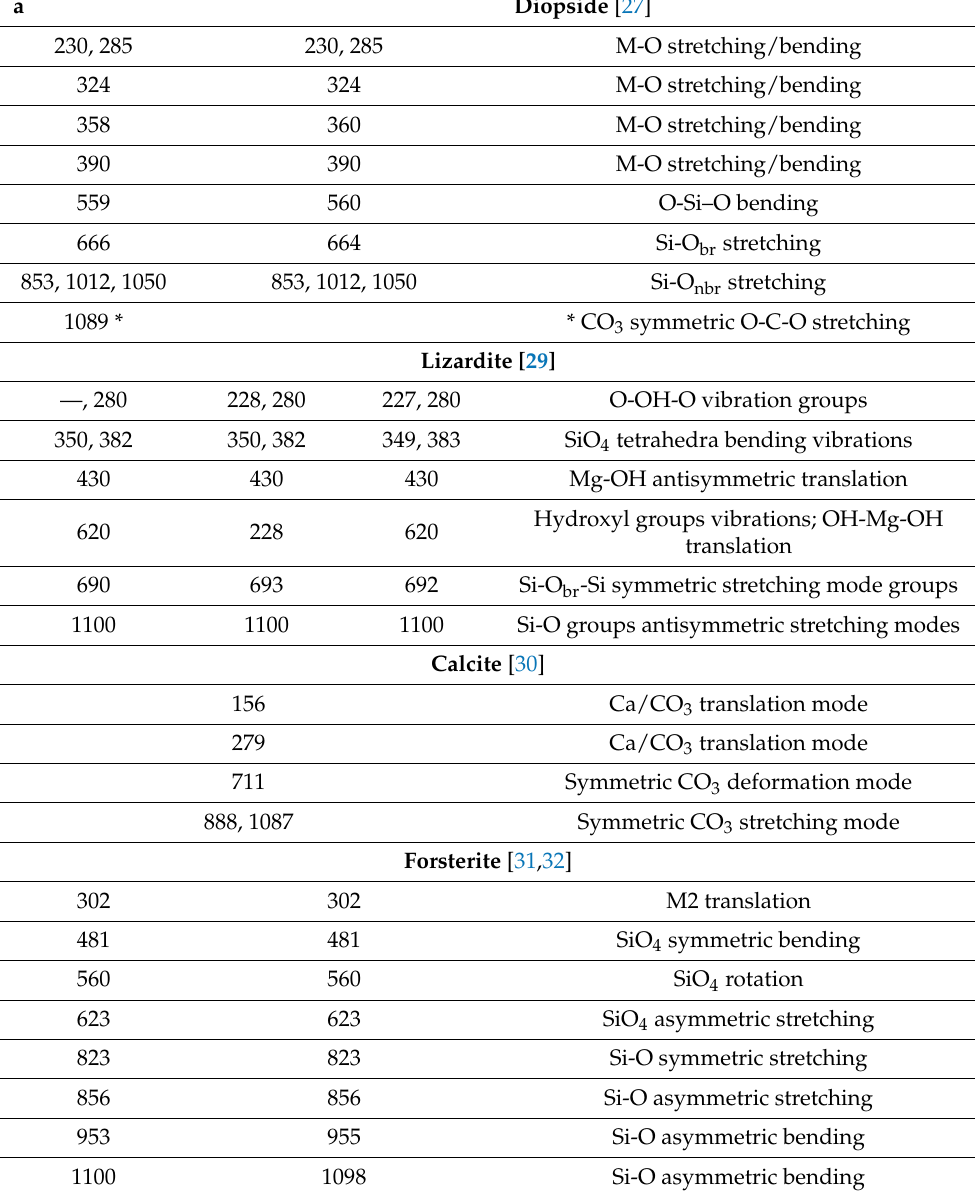
Table 6. Raman analyses on the mineral phases occurring in the diopside-bearing marbles;the band numbers and their assignments are reported: (Table a) right and (Table b) left side of the Sissonevalley. At about 1089 cm − 1 the typical absorption band of calcite is